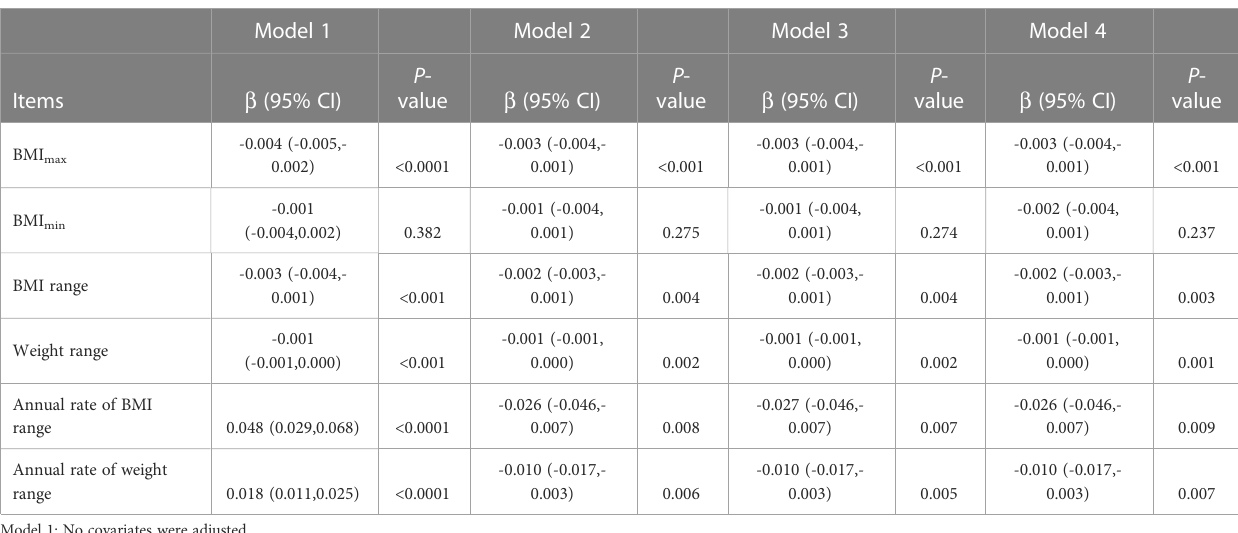
TABLE 2 Association of telomere length (T/S ratio) with the weight range.